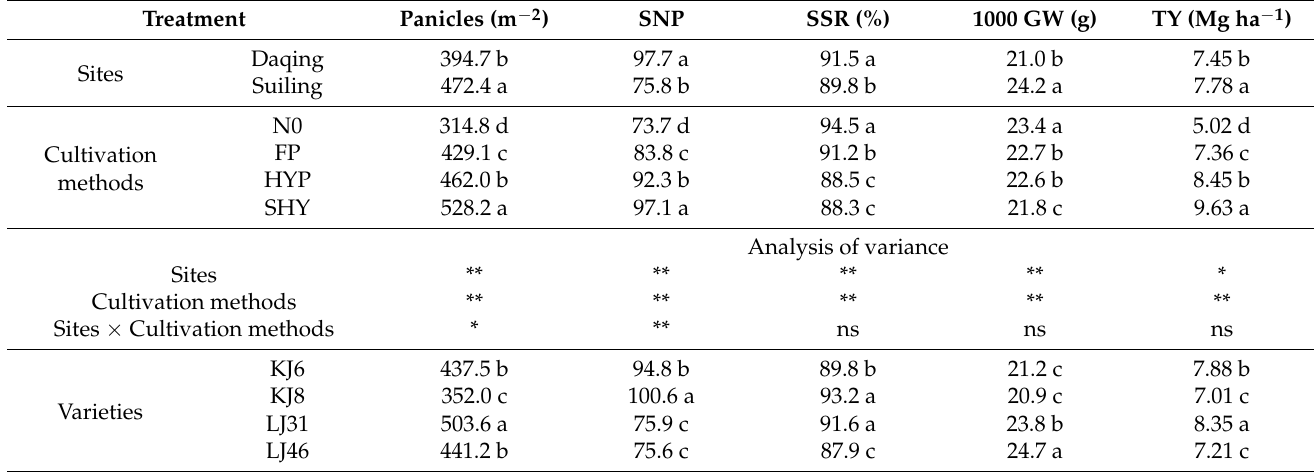
Table 2. Rice yield and yield component response to different sites, varieties, and cultivation